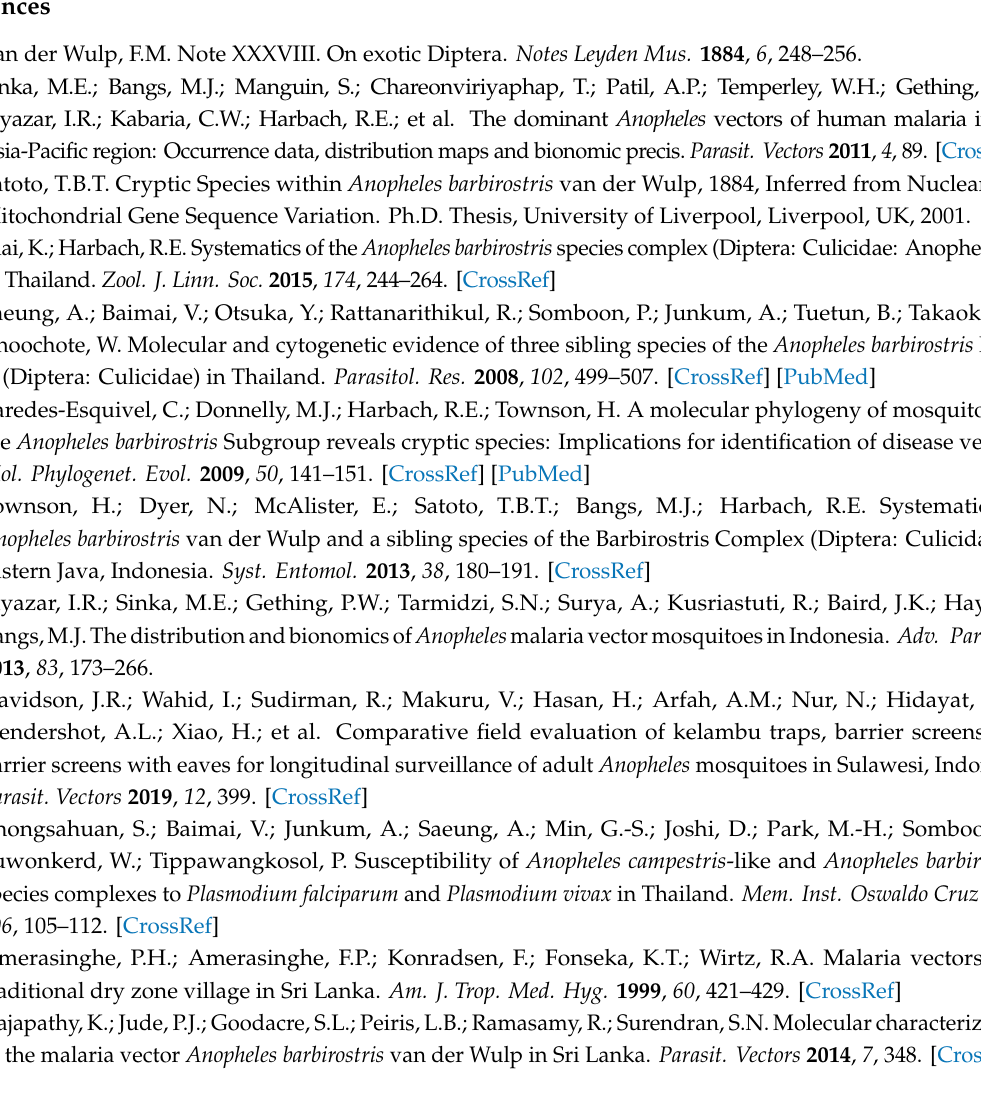
Figure S1. Alignments of COI sequences of An. barbirostris s.l. from GenBank used for designing specific primers for An. barbirostris s.s. (yellow), An. saeungae (green), An. wejchoochotei (pink), An. barbirostris A3 (blue) and An. dissidens (gray). Dots ( · ) indicate identity of nucleotides within the alignment; Figure S2. Alignments of the COI sequences of the 111 specimens and GenBank sequences included in the study. Dashes (–) indicate alignment gaps and dots ( · ) indicate identity of nucleotides within the